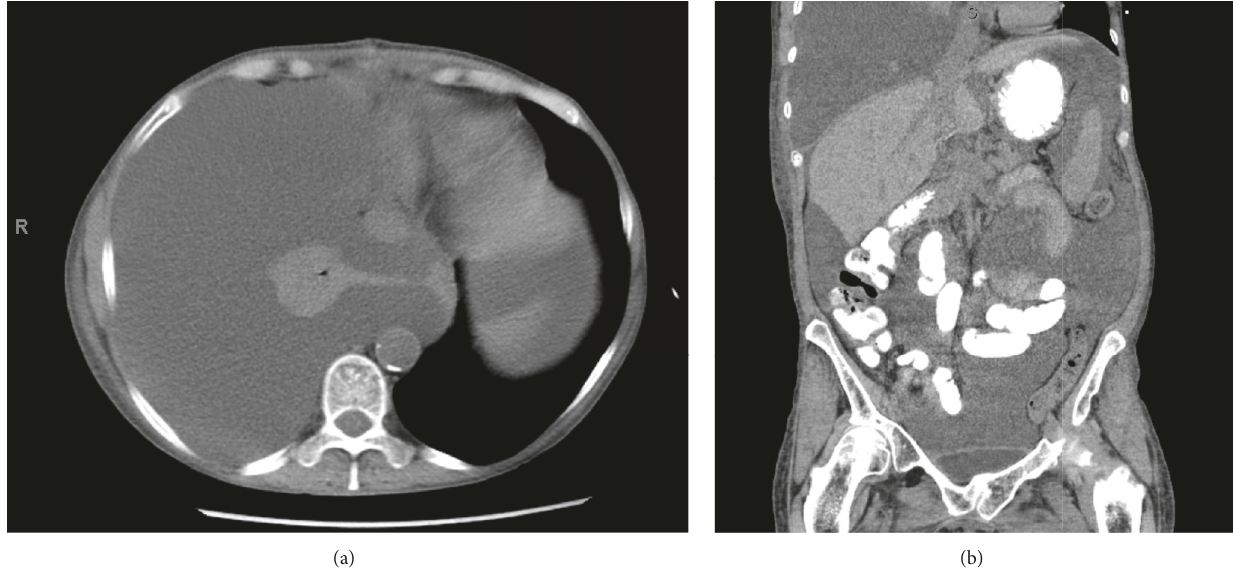
Figure 1: (a) Axial CT demonstrating large right pleural effusion with right lung atelectasis (b) Coronal CT scan demonstrating right chylothorax and chylous